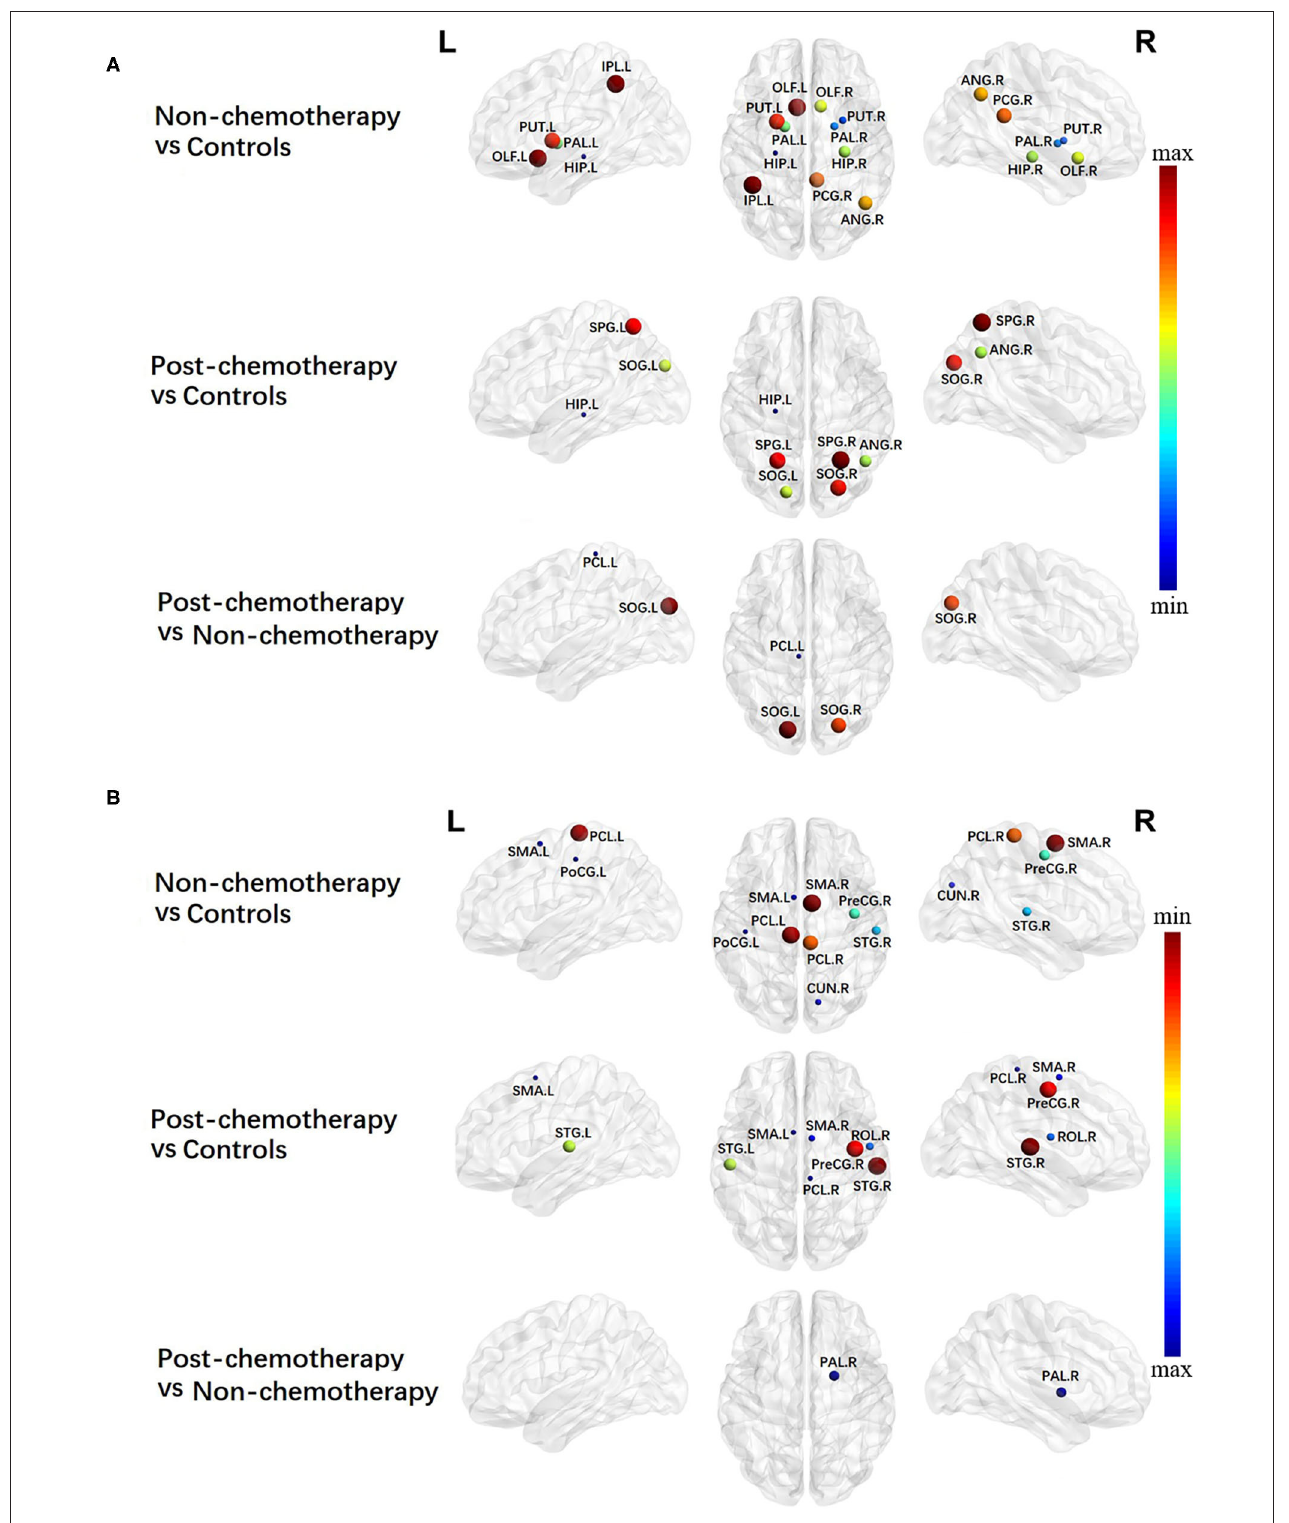
FIGURE 3 | Regions showing increased (A) and decreased (B) nodal efficiency in non-chemotherapy compared with healthy controls, post-chemotherapy compared with healthy controls, and post-chemotherapy compared with non-chemotherapy. Correction for multiple comparisons was performed using the Bonferroni